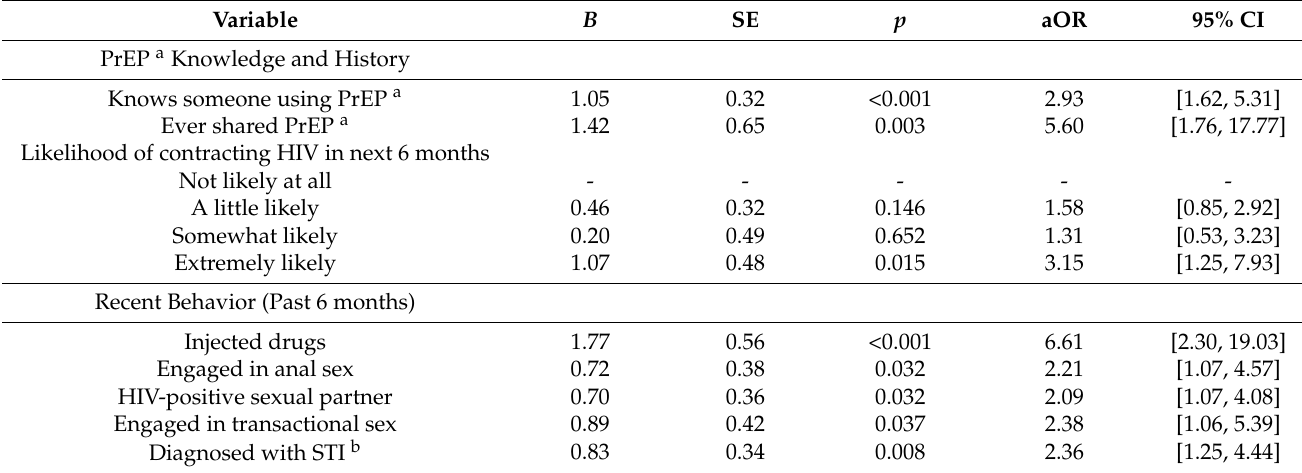
Table 3. Final multivariate logistic regression analysis of correlates of recent engagement in chemsex after backward